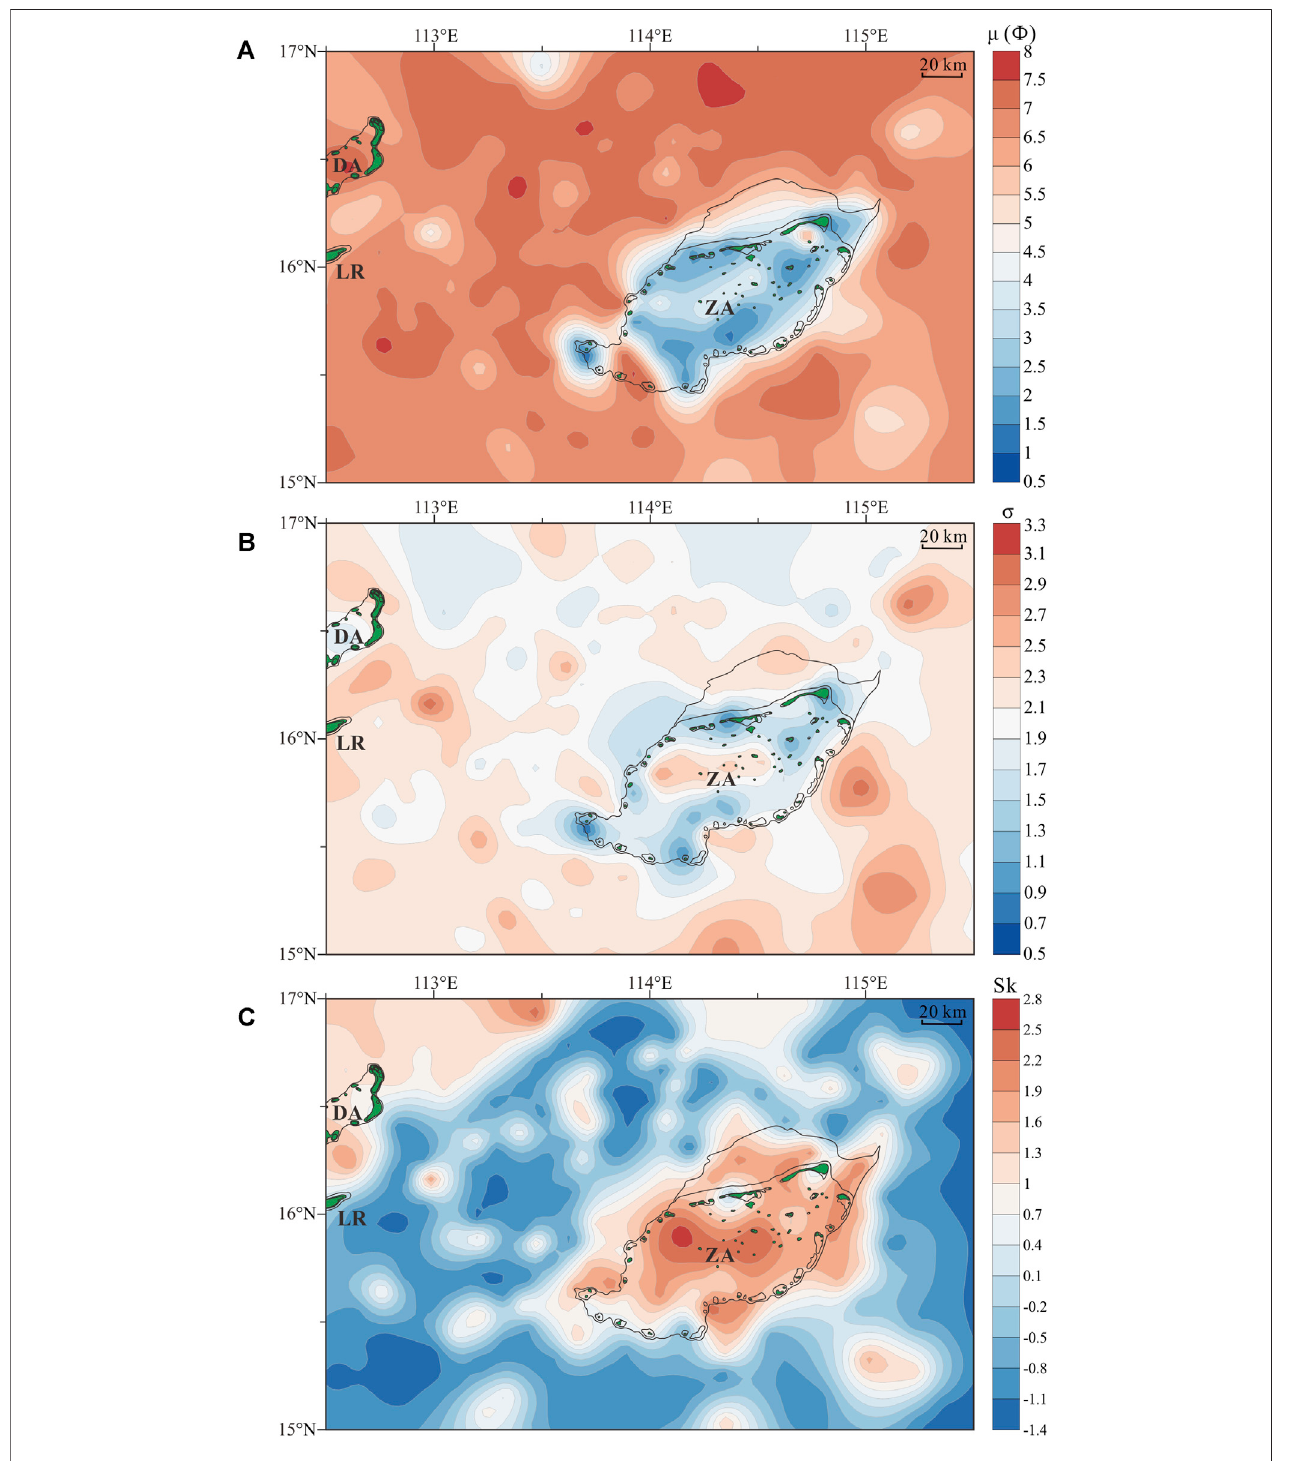
FIGURE 3 | Spatial distribution of grain size parameters in the study area, including (A) μ , (B) σ , and (C) Sk.